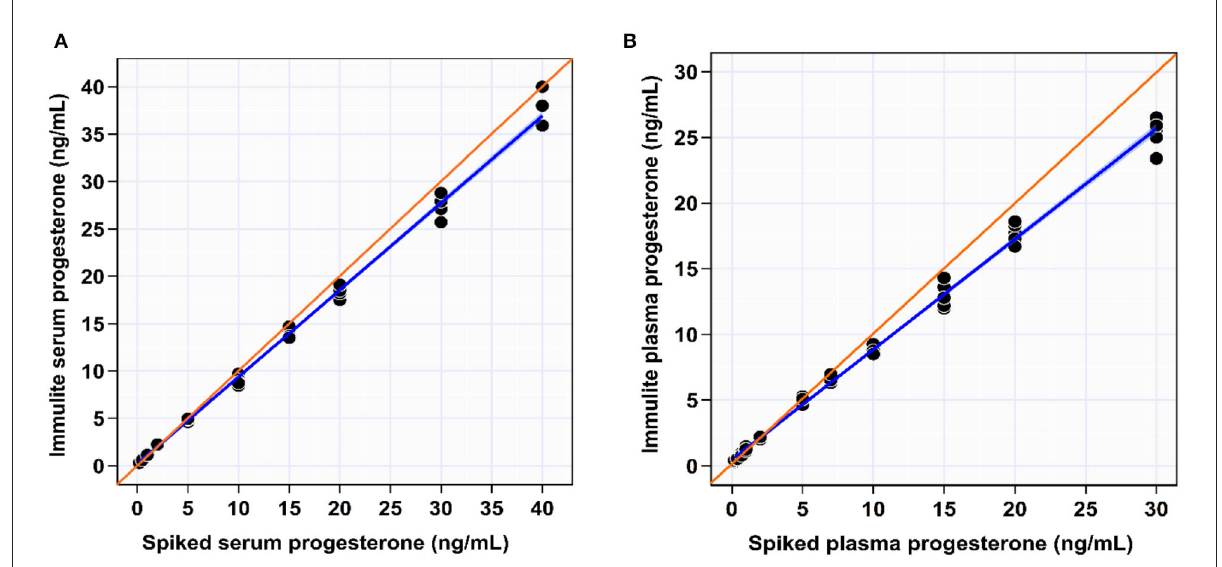
FIGURE1 Scatter plot of spiked serum (A) and plasma (B) progesterone concentrations measured by IMMULITE ® 2000 XPi P4 immunoassay with blue regression line and confidence bands for the regression lines. The identity line is orange. Regression line equation for spiked serum samples: